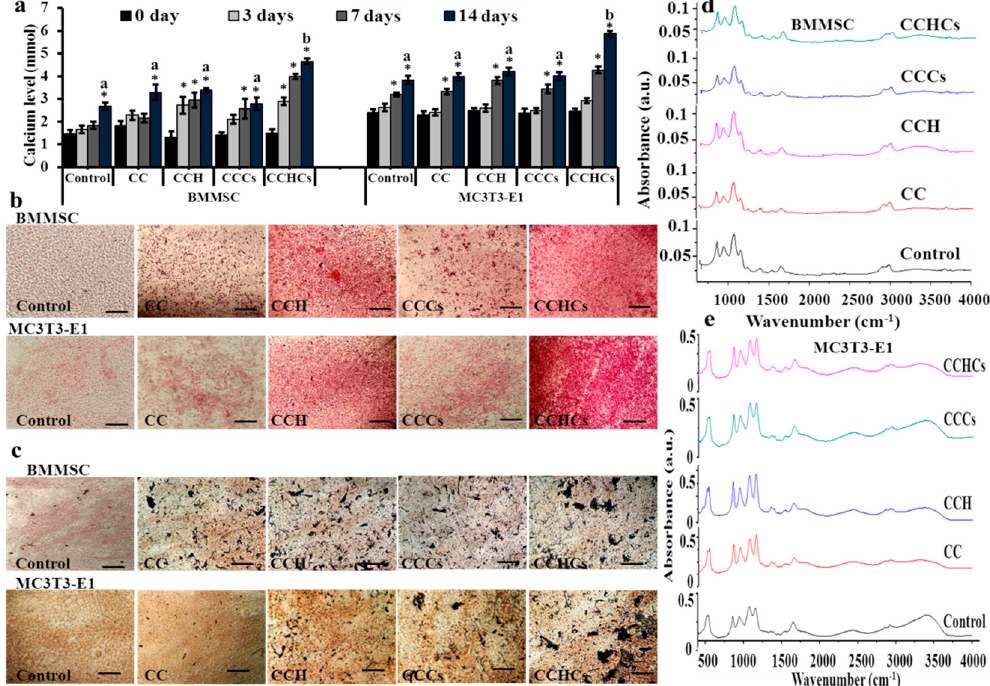
Figure 4. Cellular calcium deposition of bone cells cultured on chitosan-collagen based bio-mimic 3D matrices for 14 days. The cellular mineral level ( a ), Alizarin red ( b ), and von Kossa ( c ) staining of bone cells. Scale bars: 40 µm. The presence of apatite was confirmed using FTIR spectra ( d , e ); control-cells grown on a regular tissue culture plate. BMMSC: bone marrow-derived mesenchymal stem cells; MC3T3-E1, pre-osteoblast. CC: chitosan-collagen 3D matrix, CCH: chitosan-collagen-hydroxyapatite 3D matrix, CCCs: chitosan-collagen-chondroitin sulfate 3D matrix, and CCHCs: chitosan-collagen-hydroxyapatite-chondroitin sulfate 3D matrix. The experiments were done three (a) or two (b–e) times with similar results. * p < 0.05 vs. zero days; different letters indicate statistical significance among 3D matrices for 14 days.